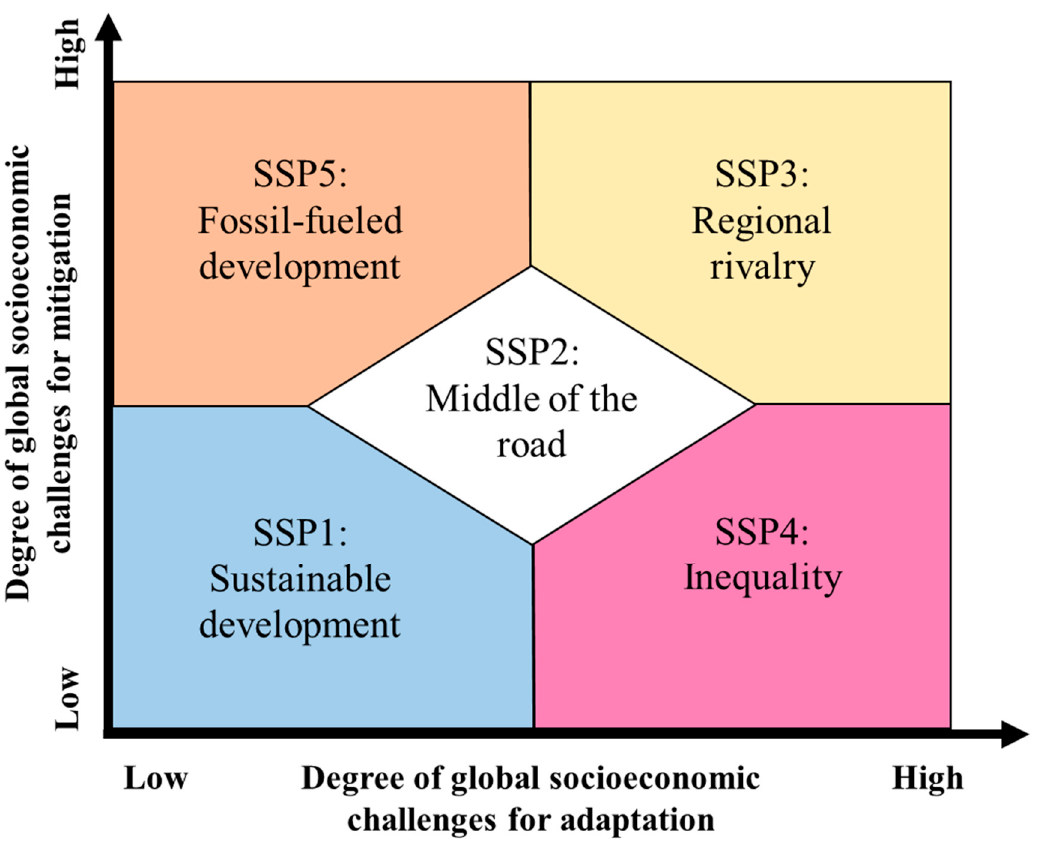
Figure 1. Shared Socioeconomic Pathway (SSP) adaptation and mitigation axes (adapted with permission from O’Neill et al. [17]).